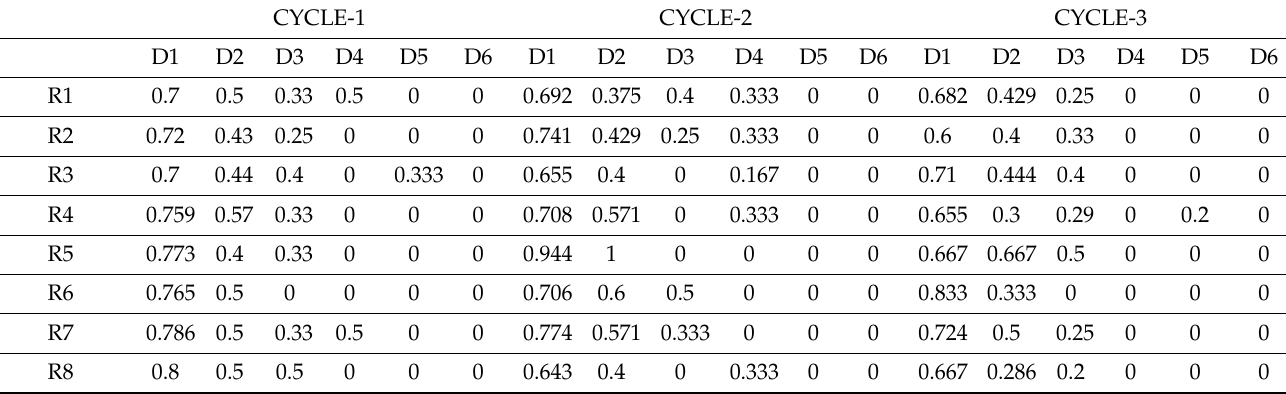
Table A2. Probability of selling of breads per cycle per